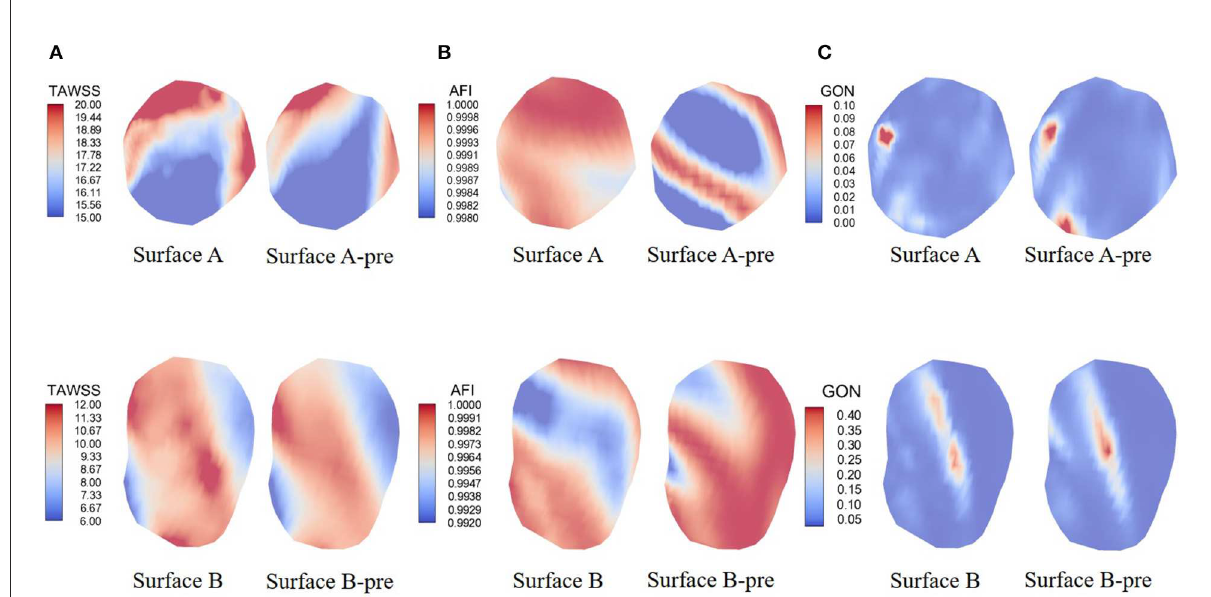
FIGURE4 Hemodynamics map comparison of two ROI presenting significant characteristics. (A–C) showed the distribution of TAWSS, AFI, and GON. Surface A represents the hemodynamic changes in the proximal aneurysm growth area when the distal aneurysm keeps intact; Surface B represents the hemodynamic changes in the distal aneurysm growth area when the proximal aneurysm keeps intact; Surface A-pre represents the hemodynamic changes in proximal aneurysm growth area when the distal aneurysms were removed; Surface B-pre represents the hemodynamic changes in distal aneurysm growth area when the proximal aneurysms were removed.